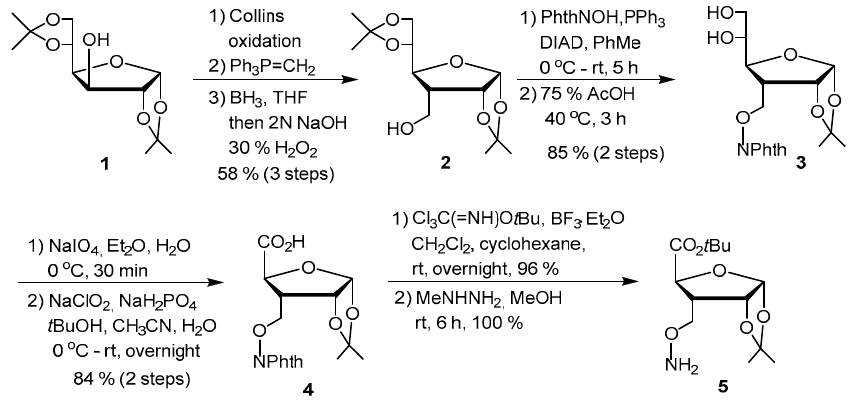
Scheme 1. Synthesis of glycofuranosidic aminooxy